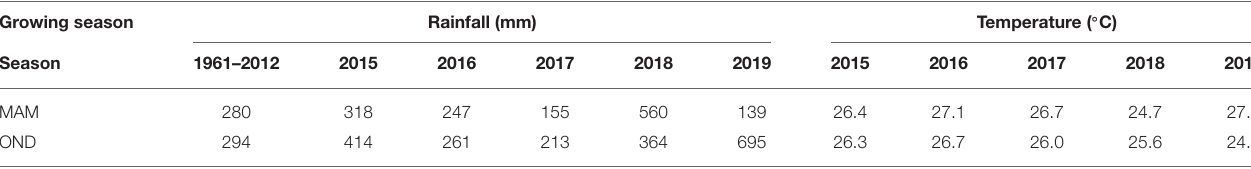
TABLE 1 | Long-term average rainfall (1961–2012) and short-term (2015–2019) average annual rainfall and temperature in the two main growing seasons in Makueni: March, April, and May (MAM) and October, November, and December (OND). Growing season Rainfall (mm) Temperature ( ◦